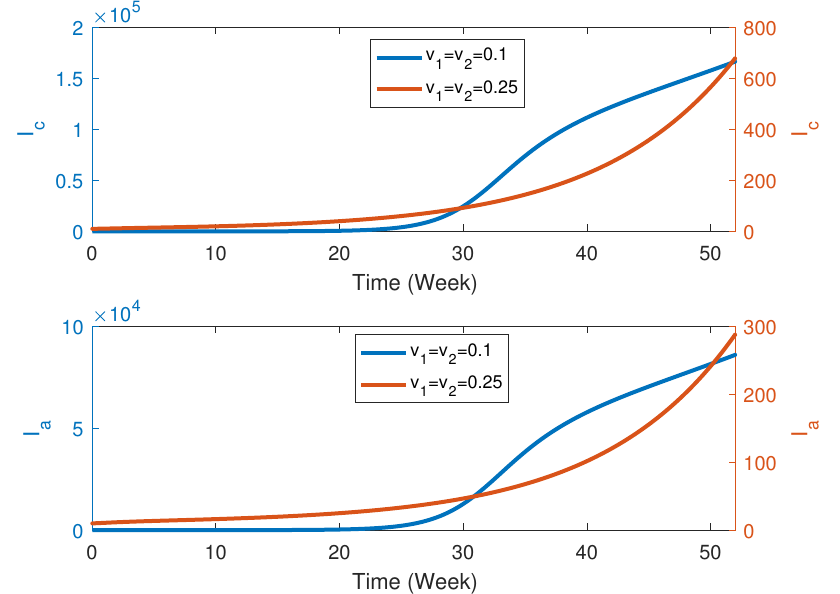
Figure 8. Simulation of infected individuals in the presence of vaccination and Wolbachia bacterium. We use the WAu parameter values. The vaccine efficacy is (cid:101) 1 = 0.5 and (cid:101) 2 =